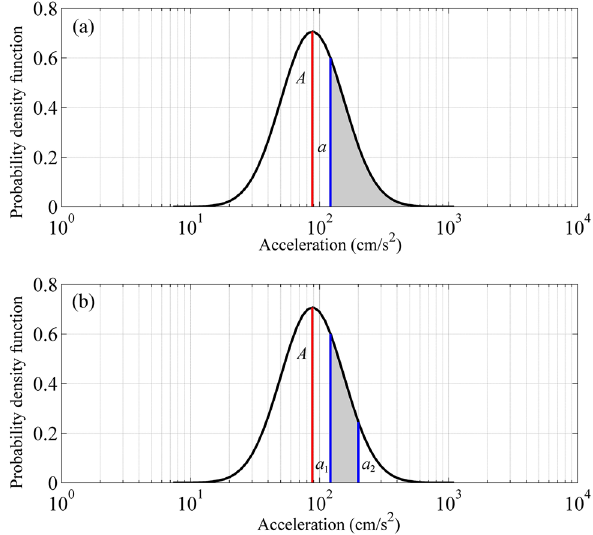
Fig. 5 a The probability of ground motion generated by an earth- quake exceeding a given value (grey shaded area). b The probabil- ity of ground motion generated by an earthquake in a certain ground motion interval (grey shaded area). A is the ground motion generated by an earthquake at the site. a is a given ground motion value. [ a 1 a 2 ] is a given ground motion interval that corresponds to a modified Mer- calli intensity